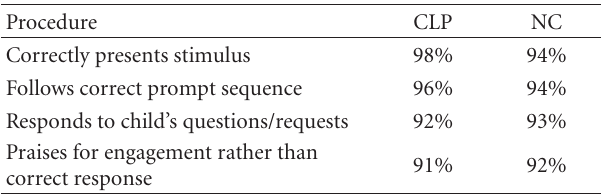
Table 1: Percent agreement for procedural components of the PEEPS assessments for the children with CLP and NC